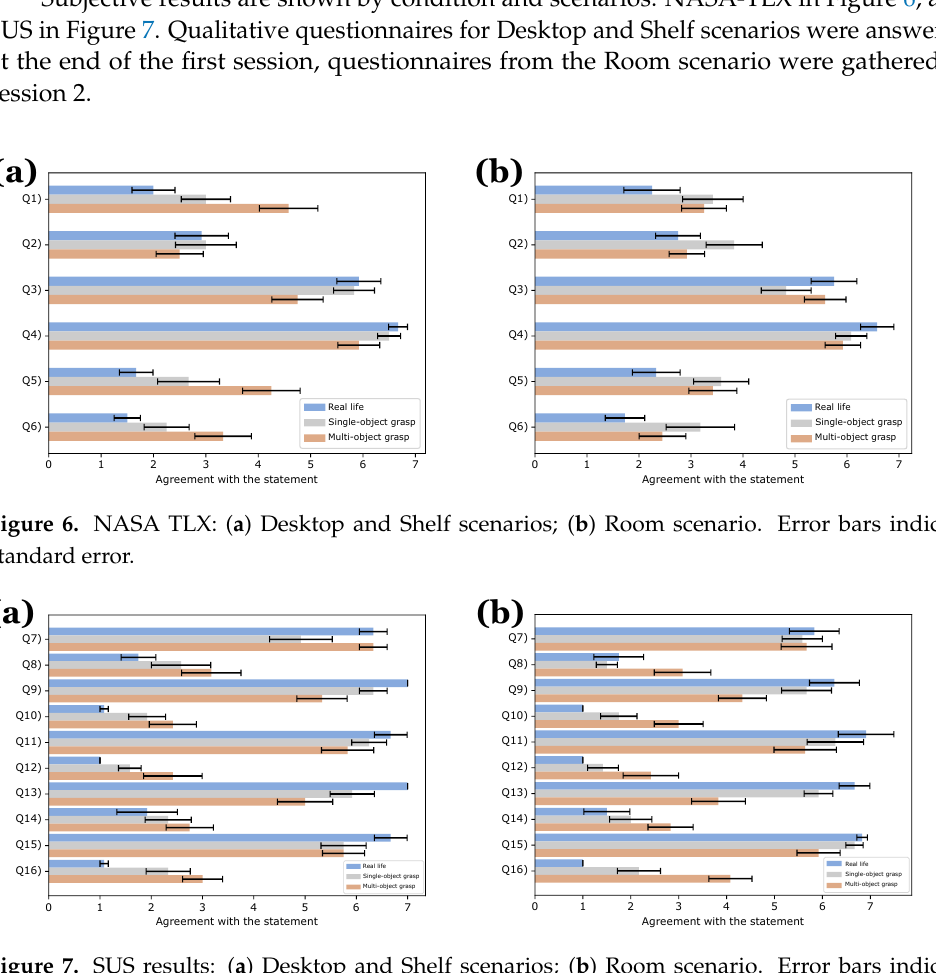
Figure 7. SUS results: ( a ) Desktop and Shelf scenarios; ( b ) Room scenario. Error bars indicate standard